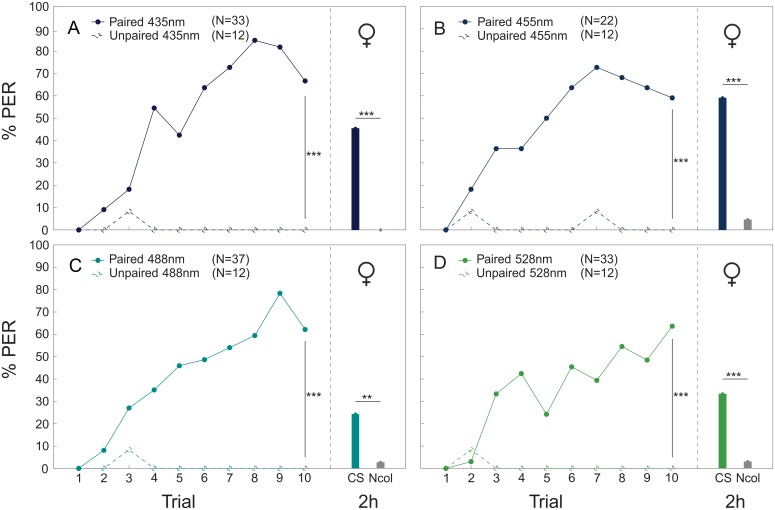
Absolute color conditioning and memory retrieval in workers.Acquisition curves (proportion of bees that responded to the tested color stimulus by extending the proboscis [% PER]) of workers during absolute conditioning of four different color stimuli (A: 435 nm, B: 455 nm, C: 488 nm and D: 528 nm). Workers were trained either with a paired (filled circles) or an unpaired (empty circles) presentation of CS and US. Memory retrieval was tested by presenting the CS (colored bar) and a novel color stimulus (NCol: gray bar) to the bees 2h after conditioning. *** P < 0.001; ** P < 0.01.